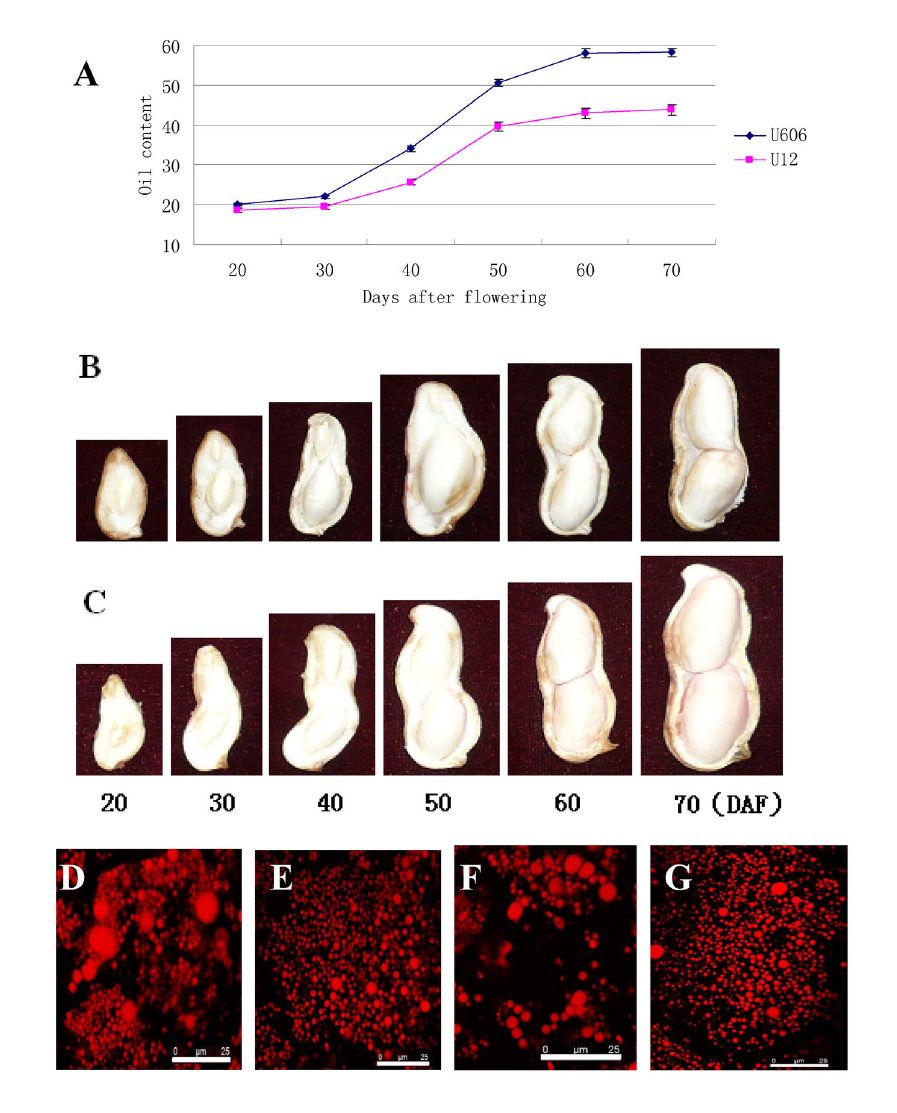
Figure 1. The development period of peanut seeds. (A) Time courses of oil accumulation in developing peanut seeds. Values are the average of two independent measurements, and the same seed material used. (B) The development period of U12 seeds. (C) The development period of U606 seeds. (D) and (E) A confocal section of a U606 seed at 30-40 DAF and 50-60 DAF and stained with Nile red. (F) and (G) A confocal section of a U12 seed at 30-40 DAF and 50-60 DAF and stained with Nile red. Bars = 25